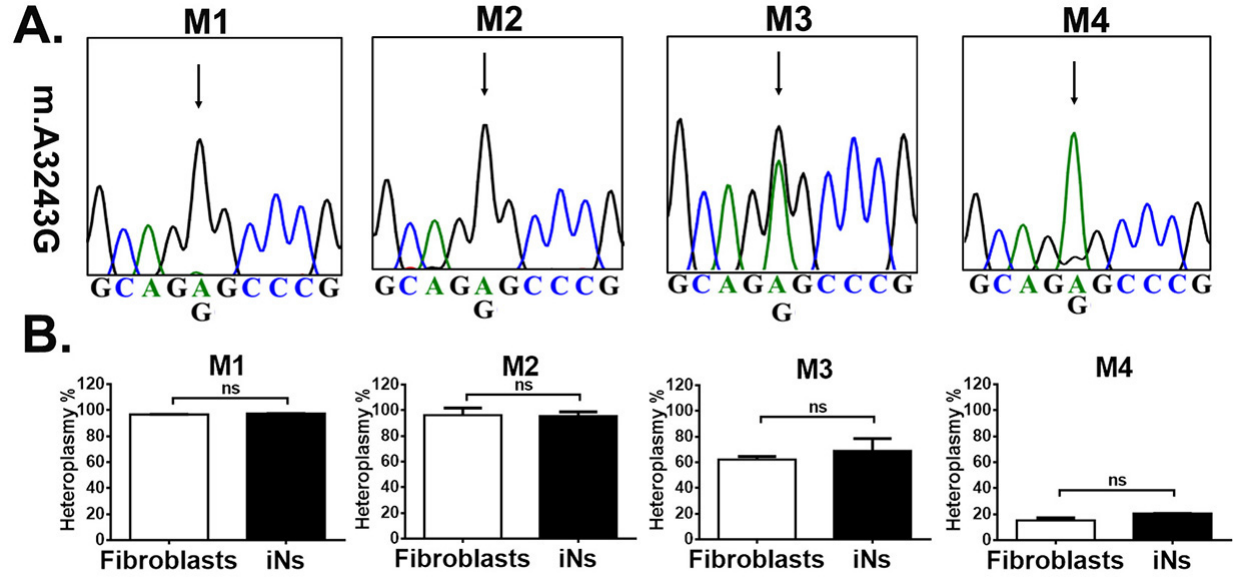
Figure 2. Heteroplasmy of MELAS fibroblasts and MELAS iNs. ( A ) Sequencing chromatogram shows the heteroplasmic m.A3243G mutation in fibroblasts derived from MELAS patients (M1, M2, M3, M4). ( B ) Heteroplasmy levels of m.A3243G mutation quantified through qPCR assay in MELAS fibroblasts and MELAS iNs derived from MELAS fibroblasts. Results are expressed as mean ± SD of three independent experiments. Statistical significance was calculated using Student’s t test. ns: not significant.